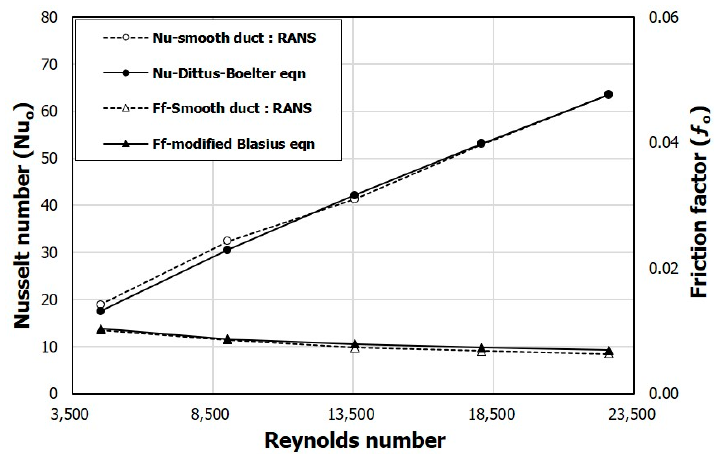
Figure 3. Validation of numerical results for smooth duct.